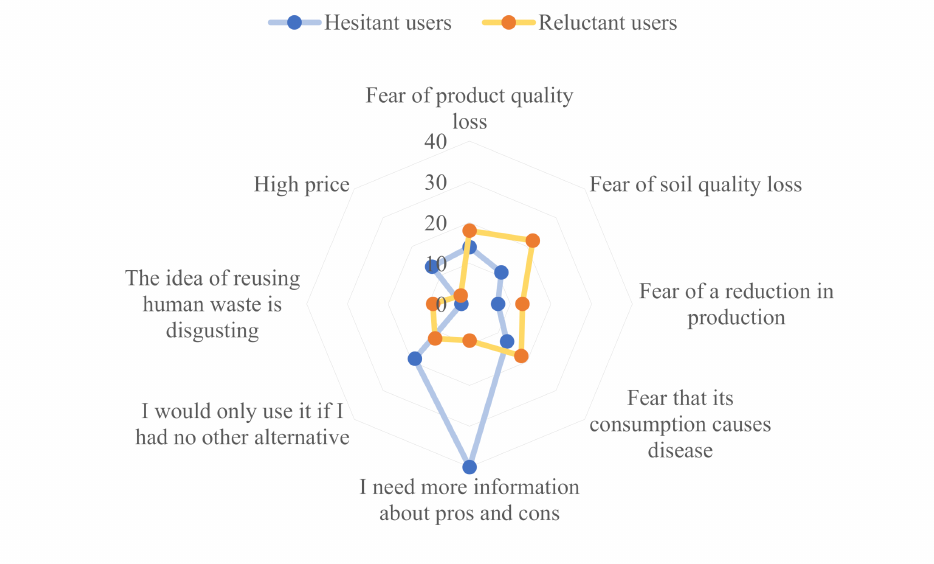
Figure 7. Farmers’ reasons for hesitating or rejecting the idea of using reclaimed